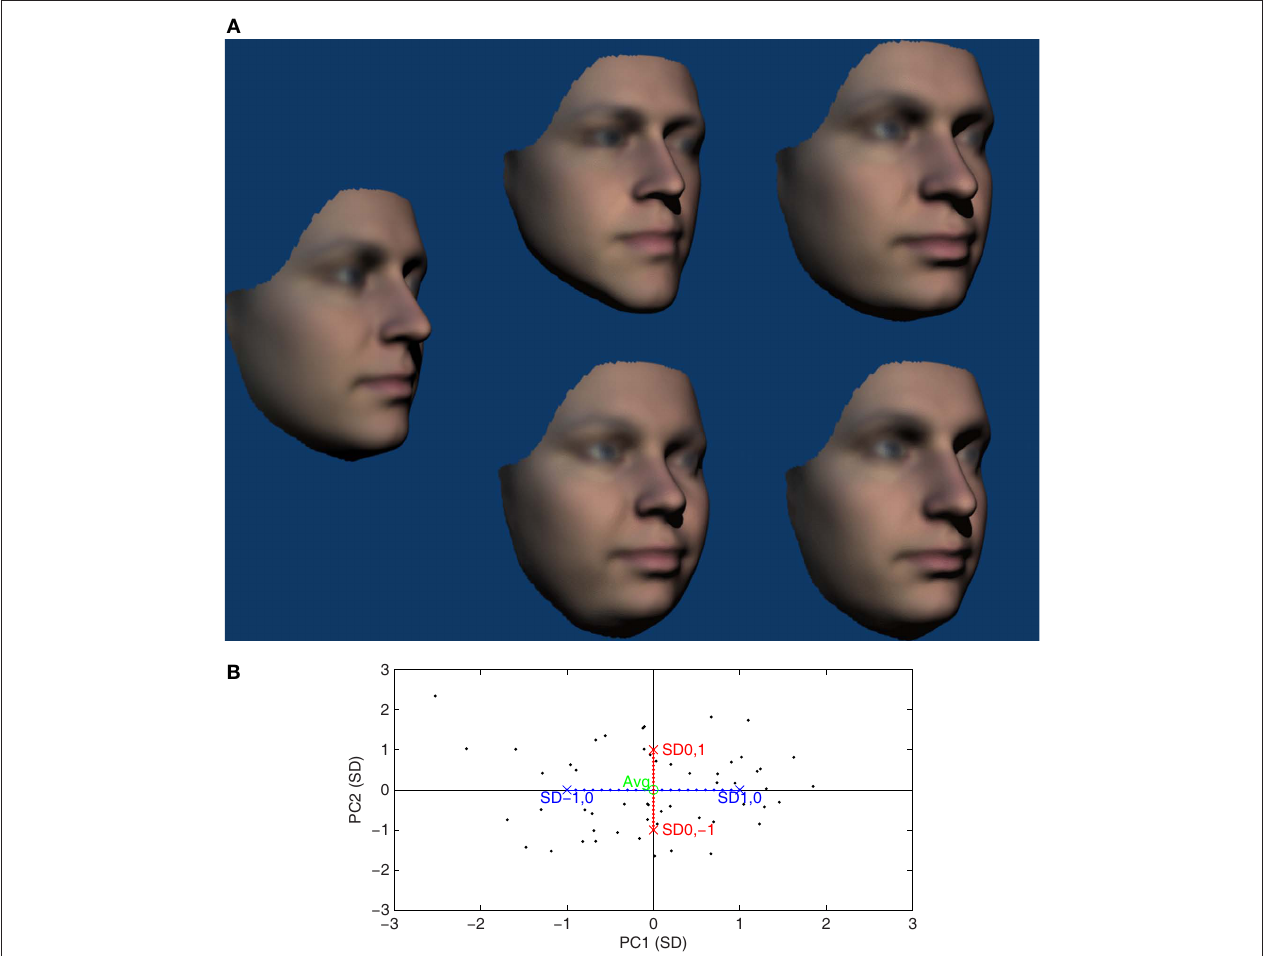
the face-space used for Experiment 2. Black points show locations of the 54 faces used to define the face-space. The locations of the average reference face and the PC1 zero and PC2 zero